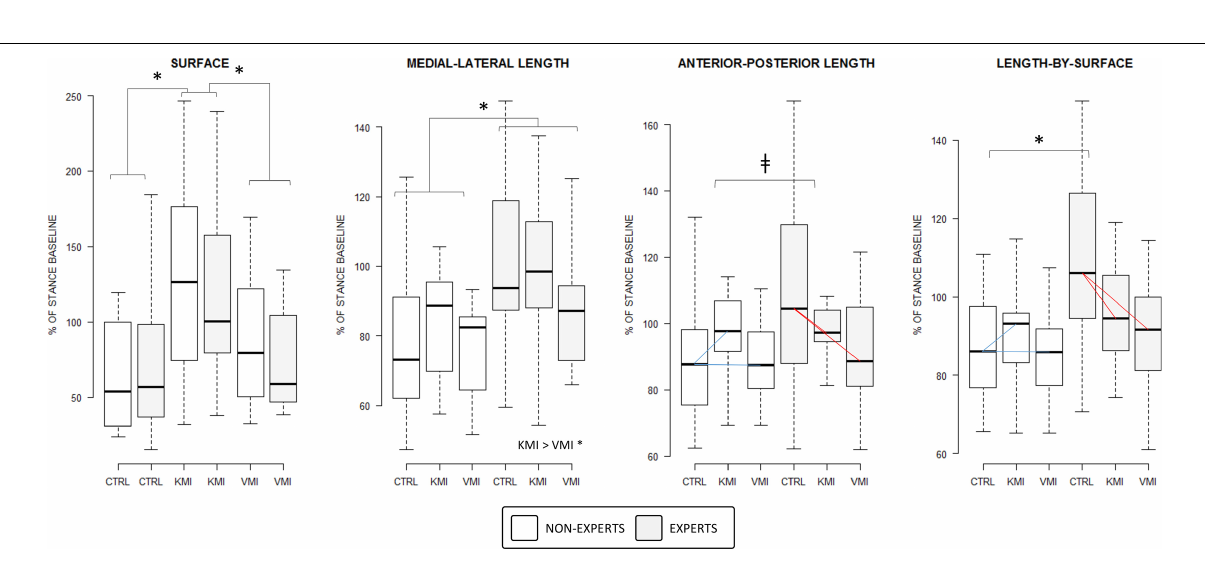
FIGURE 3 | Boxplot representation of the CONDITION by GROUP interaction effect on stabilometric variables calculated in the time domain. Differences of differences are represented by a color code emphasizing distinct slopes patterns materializing differences across experimental conditions in the experts groups and non-experts for the length of COP displacement in the anterior-posterior axis and length-by-surface of COP displacement only. ∗ p < 0.05, † p < 0.10. CTRL: Control. KMI: Kinesthetic Motor Imagery. VMI: Visual Motor Imagery. η 2 = 0.15) and AP-Length ( F (1, 23) = 3.24, p = 0.04, η 2 = 0.12; p p Figure 5A ). Stabilometric data recorded during KMI,